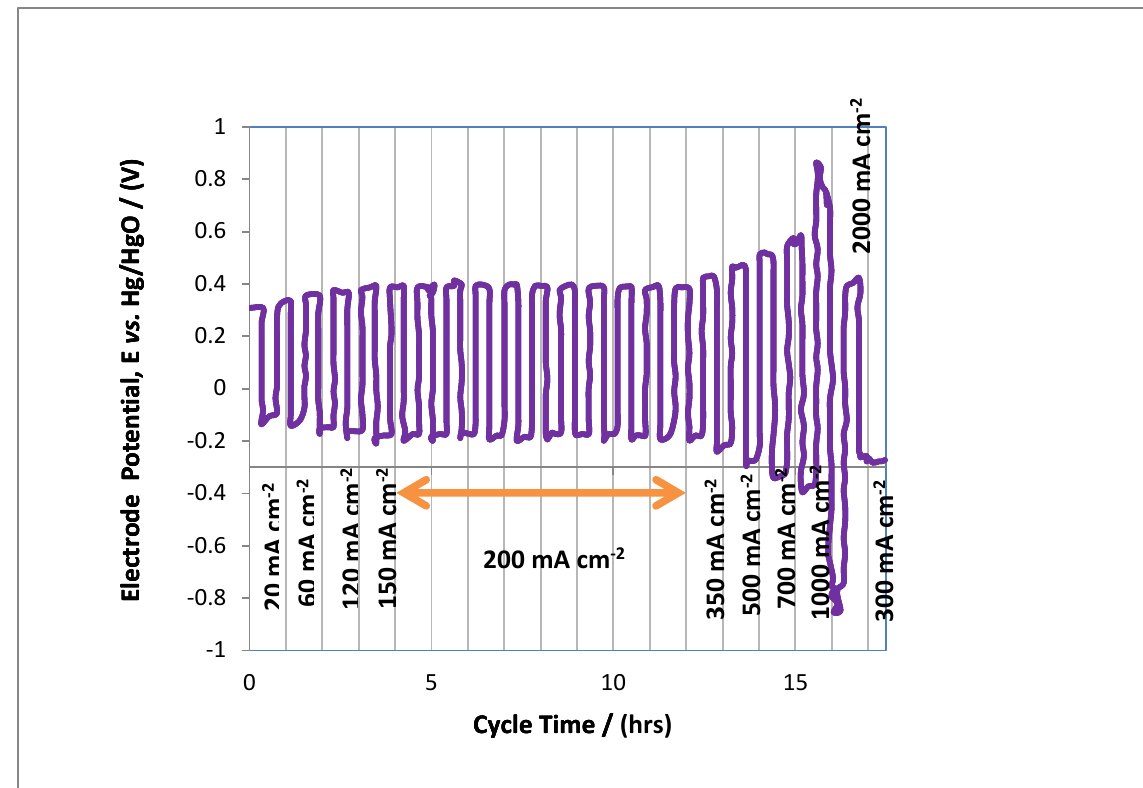
Figure 4. Cycling performance of a MAB at 20, 60, 120, 150, 200, 350, 500, 700, 1000 and 2000 mA cm − 2 of current densities. The cycling time was intervals of 60 min.